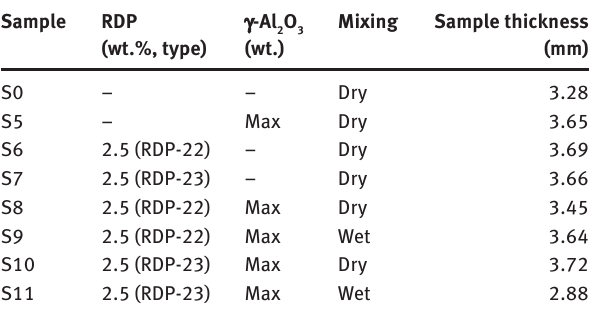
Table 1: Composition and characteristics of the investigated PCC samples.